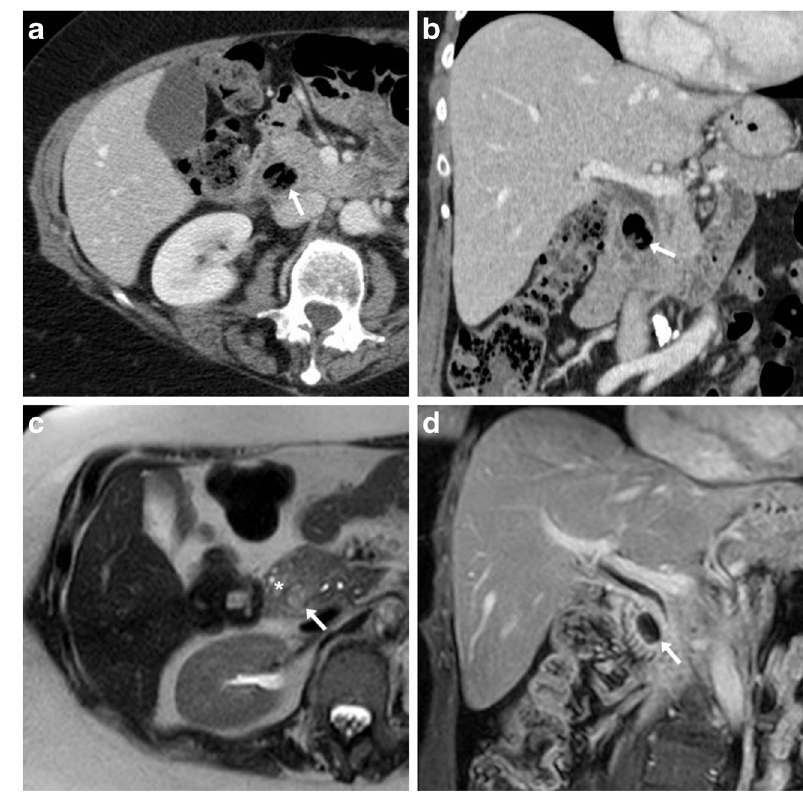
Fig. 7 In a 77-year-old female with recurrent upper abdominal pain, axial ( a ) and coronal ( b ) post-contrast CT images showed a duodenal diverticulum (arrows) filled by air and enteral material, in typical medial site at distal descending duodenum. At MRI, T2-weighted ( c ) and fat- suppressed gadolinium-enhanced T1-weighted ( d ) images respectively showed oedematous, inflamed surrounding pancreatic parenchyma (+) and hyperenhancing contour of diverticulum (arrows)